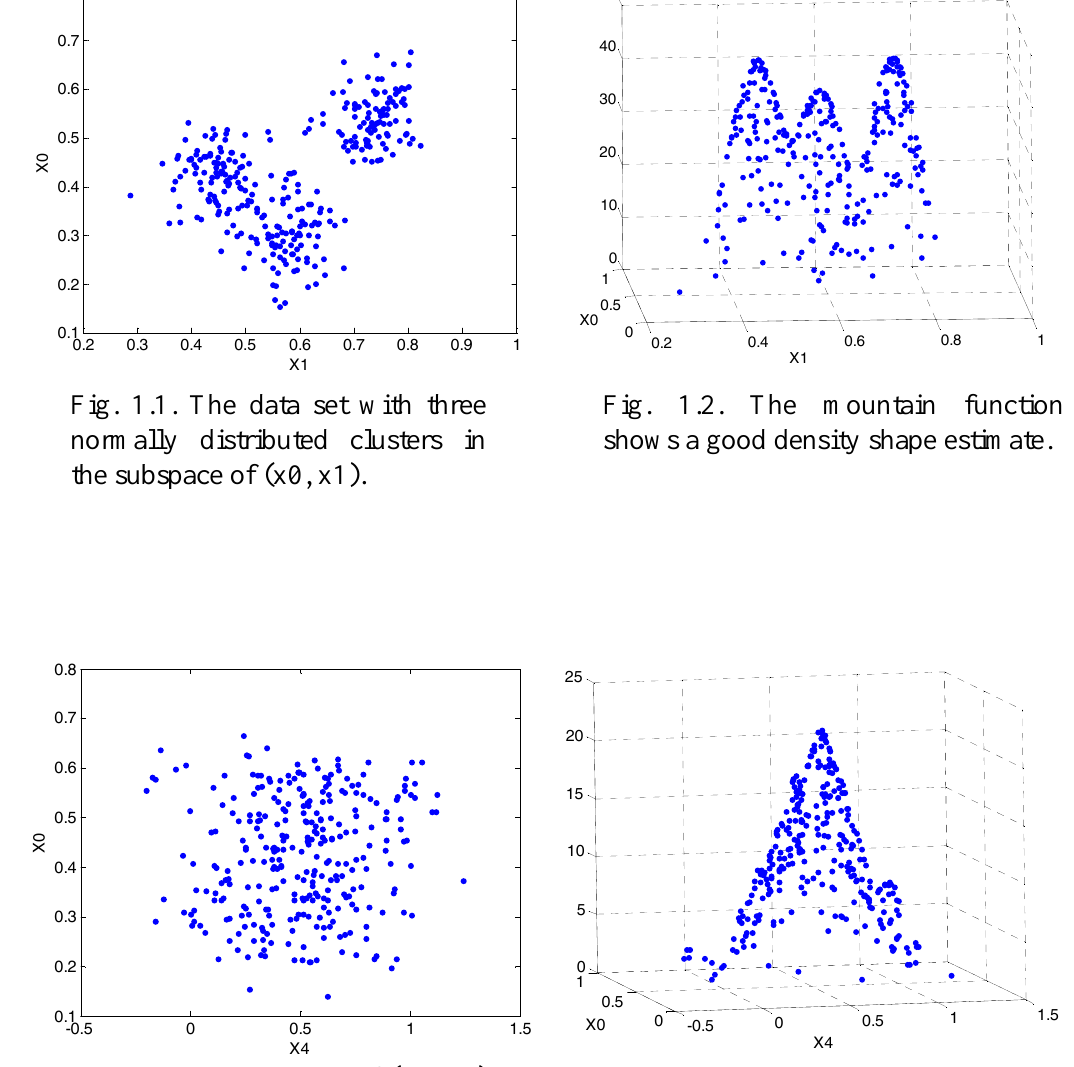
Fig. 2.1. The subspace of (x0, x4) shows three clusters but it contains a noise variable.